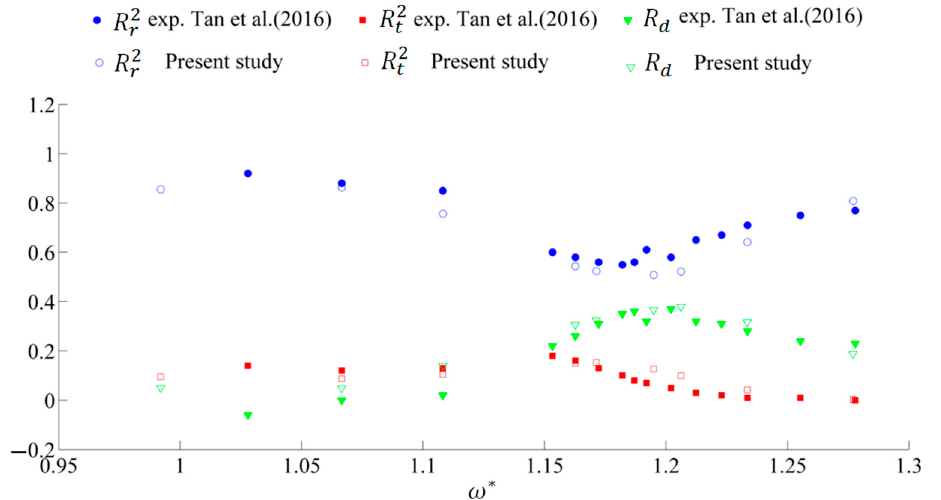
Figure 10. The square of transmission ratio R t 2 , the square of the reflection ratio R r 2 , and the dissipation ratio R d versus the incident wave frequency ω ∗ in the present study and in the experiments conducted by Tan et al. [4] ( B ∗ g = 0.1 ).